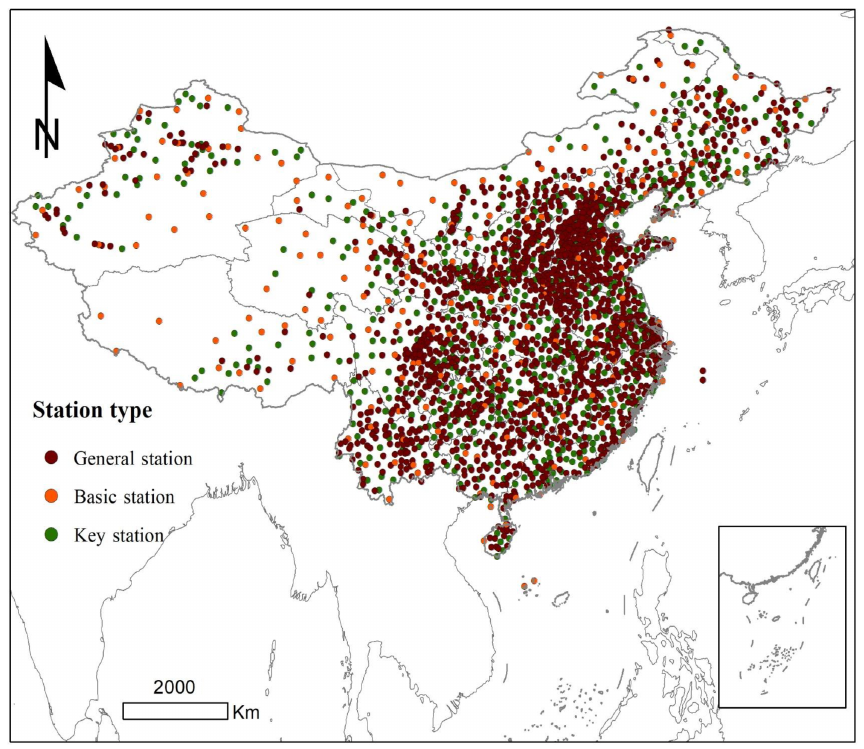
Figure A1. Distribution of China’s national meteorological stations (CNMSs) and China’s agrometeorological and ecological observation network stations (general station, basic station and key station).